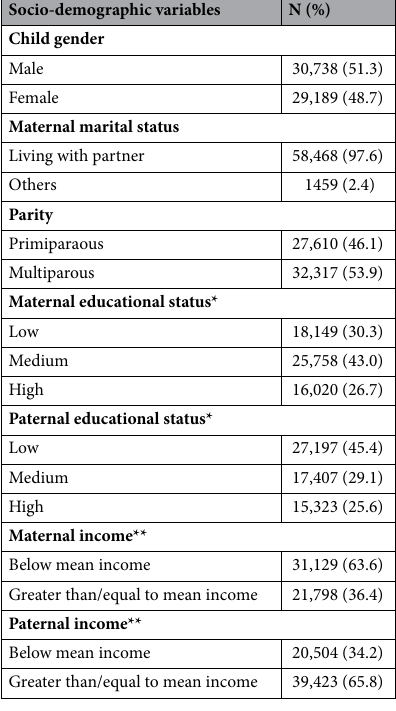
Table 1. Socio-demographic characteristics of family/child pairs included in this study (N = 59,927). *Low: completed ≤ 12 years of education, medium completed 13–16 years of education, and high completed ≥ 17 years of education. **Below mean income < 300,000 Norwegian Krone per year and greater than/equal to mean income ≥ 300,000 Norwegian Krone per